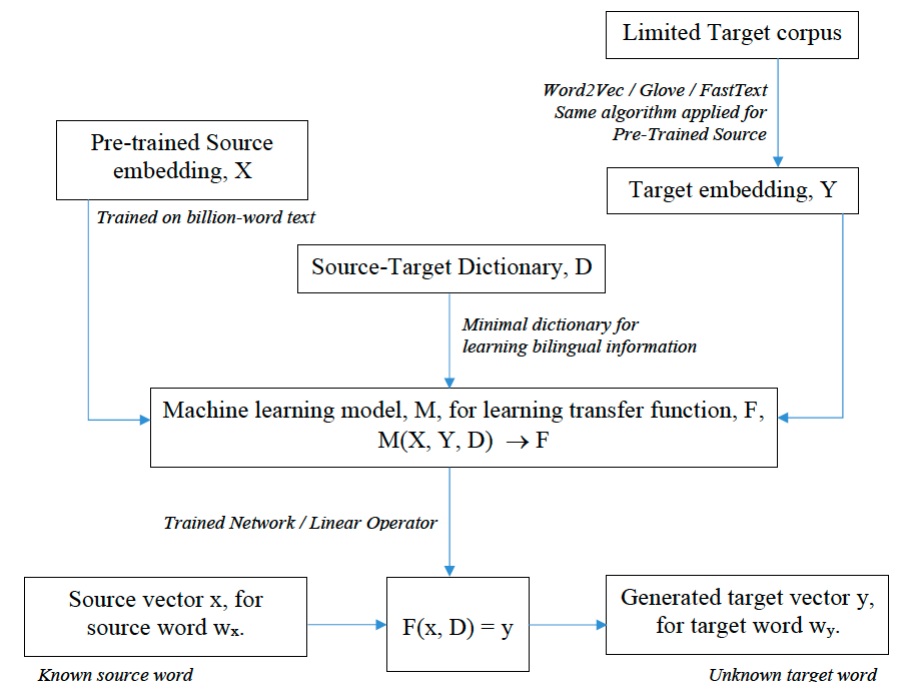
Figure 1. Flow chart of the proposed transfer learning